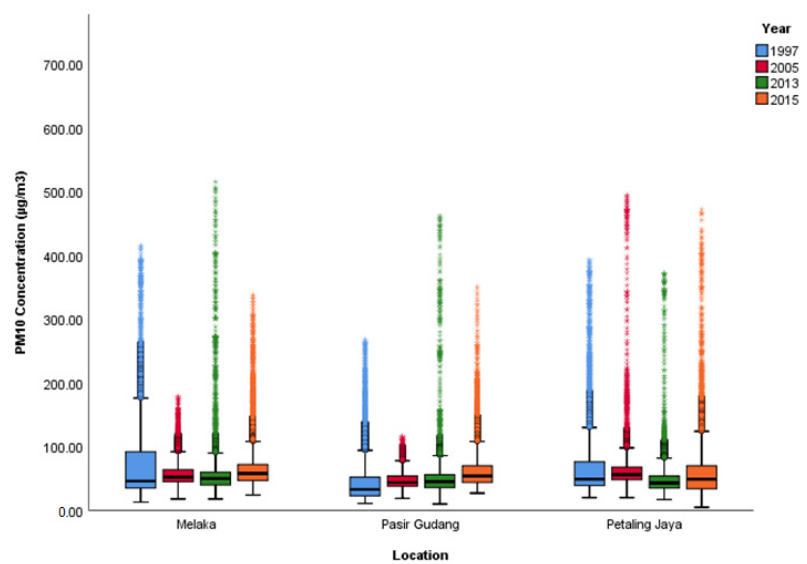
Figure 2. The box plots for PM10 concentration in Pasir Gudang, Melaka, and Petaling Jaya.